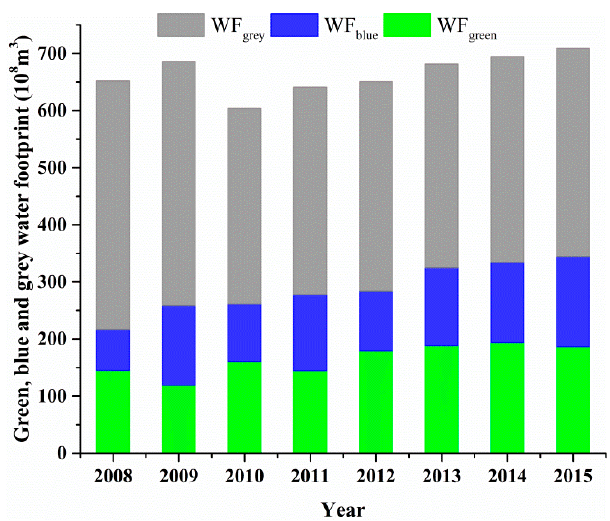
Figure 3. Green, blue, and grey water footprints (WFs) of Jilin Province from 2008 to 2015.